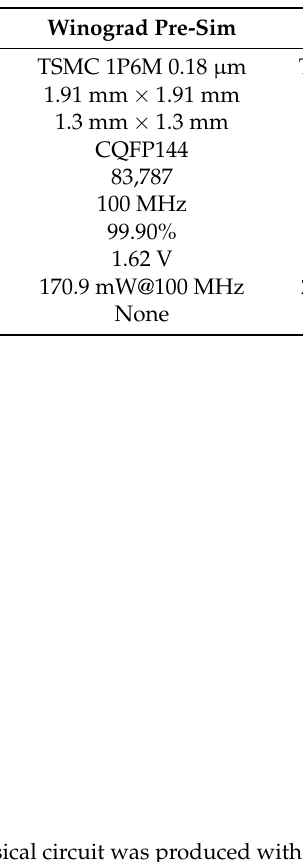
Table 1. Chip basic specifications technical.